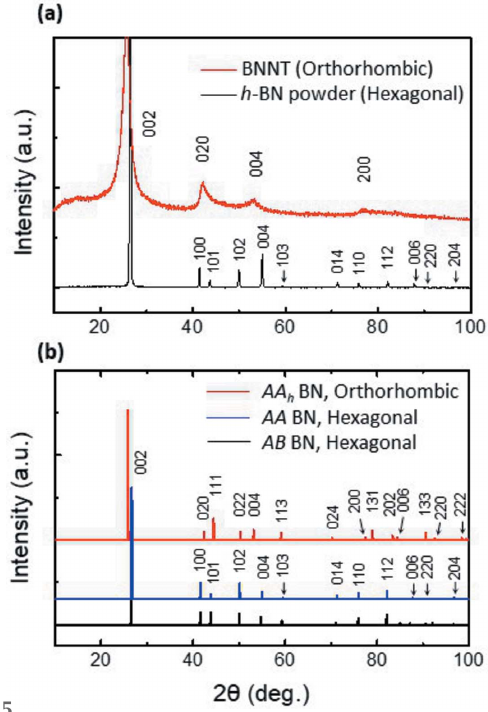
Figure 5 XRD analysis for BN structures. ( a ) XRD patterns of BNNTs and BN powders. The (020) and (200) peaks of the BNNTs (orthorhombic) are equivalent to (100) and (110) of the BN powders (hexagonal), respectively. ( b ) Simulated XRD patterns of typical BN crystals. AA h BN adopts an orthorhombic structure, while AA and AB BN (where a , b and c are 2.46 A˚ , 2.46 A˚ and 6.70 A˚ , respectively) adopt a hexagonal structure.